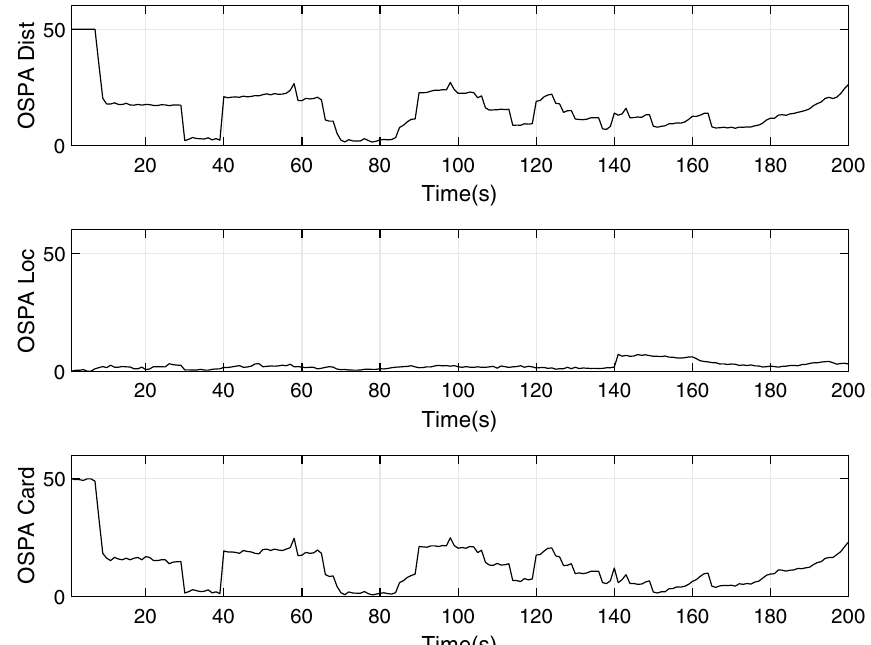
Fig. 11 The OSPA error (50MCs) with considering the blind